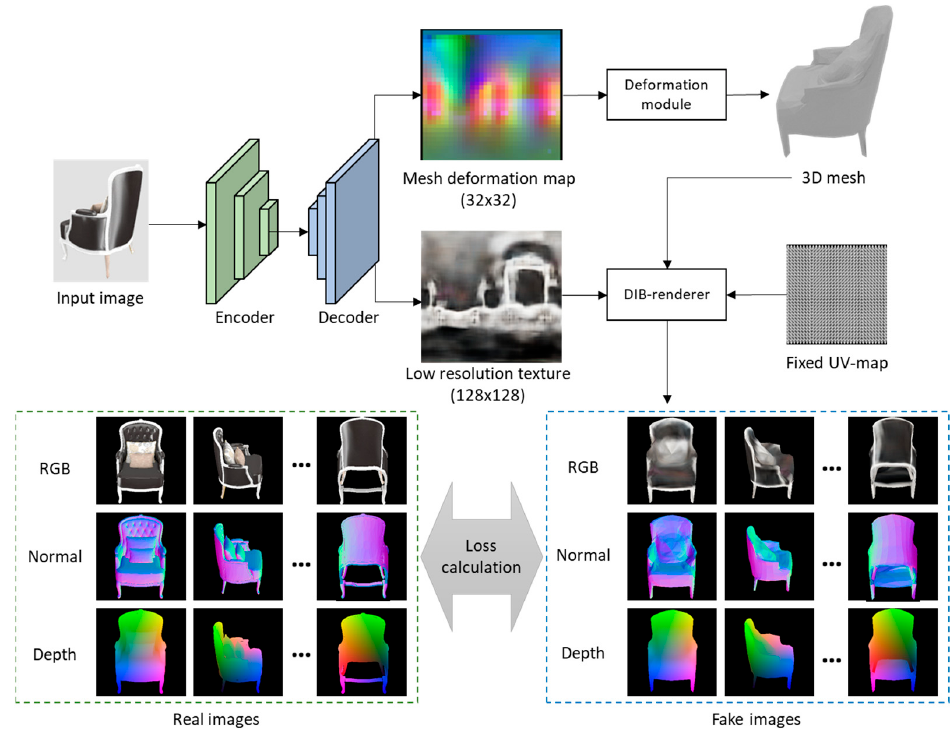
Figure 2. Training process of mesh-reconstruction network.